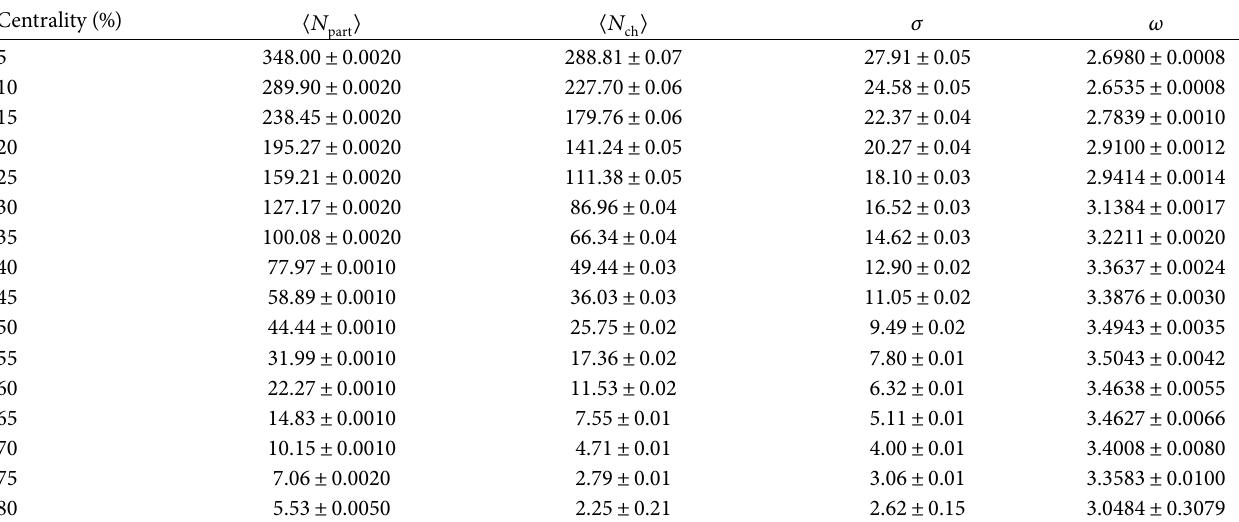
Table 2: Values of the same variables, as in Table 1, but for 𝐸 lab = 20A GeV/c.